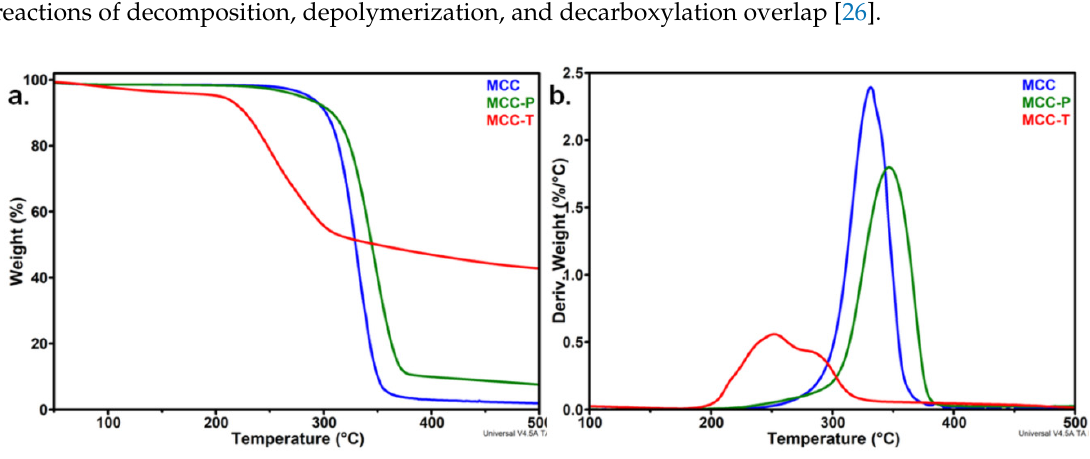
Figure 3. TGA ( a ) and DTG curves ( b ) for microcrystalline cellulose (MCC), TEMPO oxidized cellulose (MCC ‐ T) and plasma treated cellulose (MCC ‐ P) .